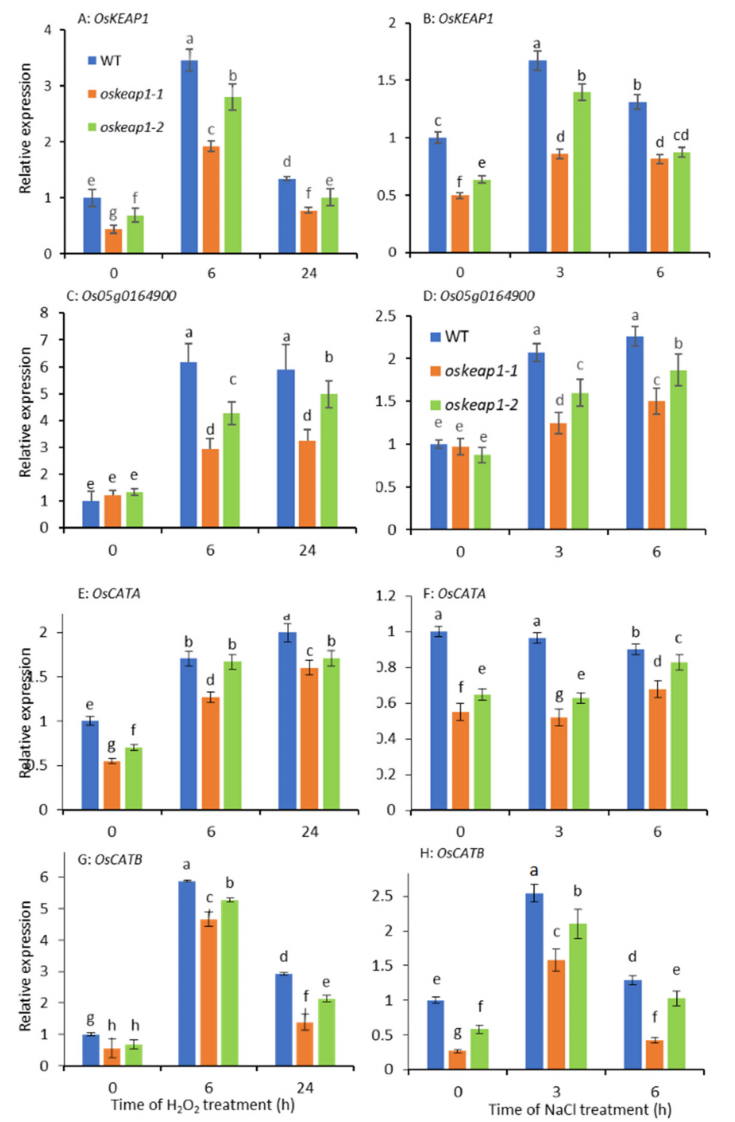
Figure 9. Relative expression of OsKEAP1 , Os05g0164900 , and two catalase genes ( OsCATA and OsCATB ) in leaf tissues of rice cultivar Xidao #1 (WT) and its two oskeap1 mutants grown under normal conditions and subjected to salt (NaCl, 200 mM) and H 2 O 2 (10 mM) treatment. OsACTIN was used as an internal reference and the expression levels were all compared with that of the WT grown under normal conditions (set as 1). Data are shown as mean ± standard error of 3 biological repeats. Data with di ff erent letters (a,b,c, etc.) represent significance at the 0.05